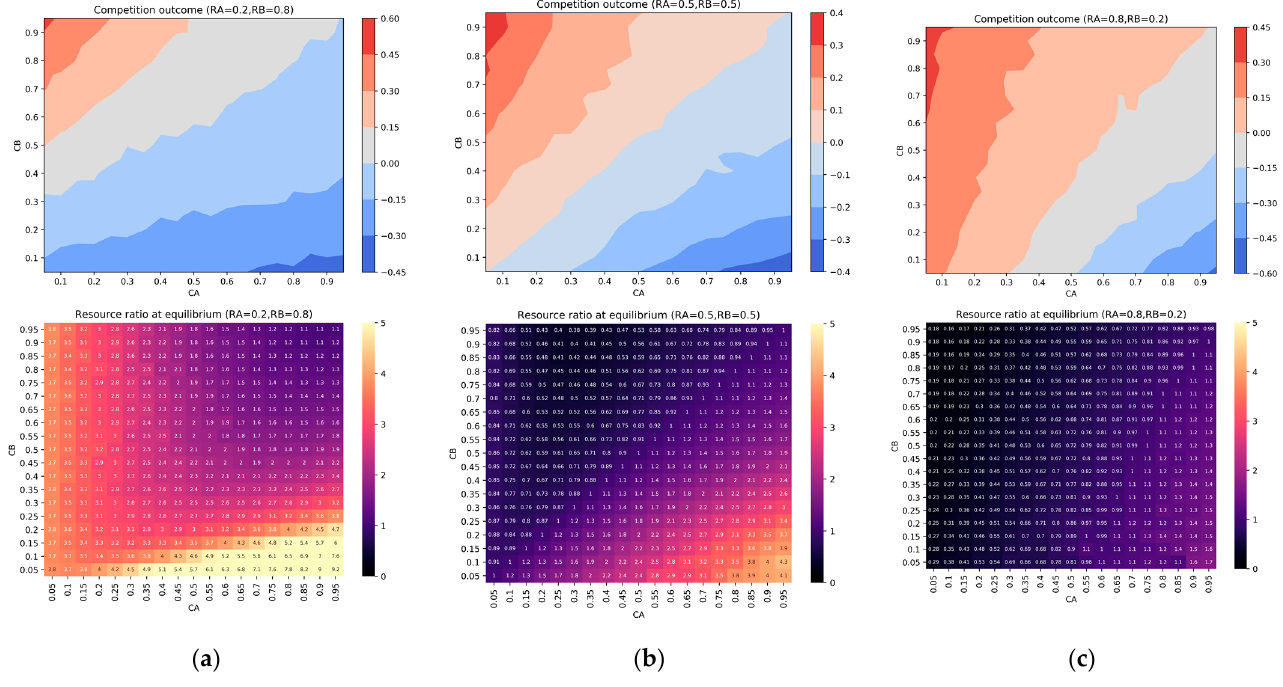
Figure 3. Average competition outcomes and average RREs of 1000 simulations under different unit costs and different pairs of budgets: ( a ) 𝑅 (cid:3002) = 0.2, 𝑅 (cid:3003) = 0.8 ; ( b ) 𝑅 (cid:3002) = 0.5, 𝑅 (cid:3003) = 0.5 ; and ( c ) 𝑅 (cid:3002) = 0.8, unit costs and different pairs of budgets: ( a ) R A = 0.2, R B = 0.8; ( b ) R A = 0.5, R B = 0.5; and 𝑅 (cid:3003) = 0.2 . ( c ) R A = 0.8, R B =